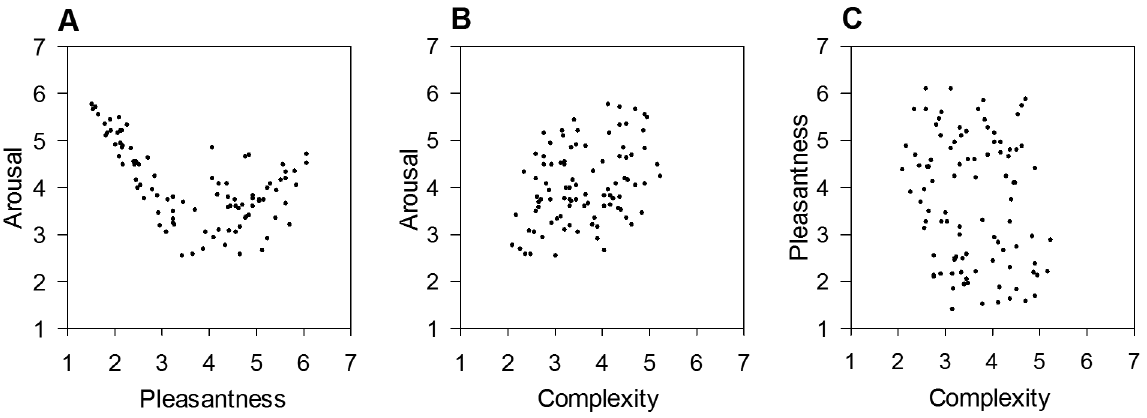
Figure 1. Relationships between pleasantness, arousal and complexity in a set of IAPS pictures. Low numbers refer to low ratings of pleasantness, arousal and complexity, respectively. A) Distribution of IAPS pictures in the pleasantness-arousal space based on mean ratings per picture. B) Relationship between mean complexity and arousal ratings. C) Relationship between mean complexity and pleasantness